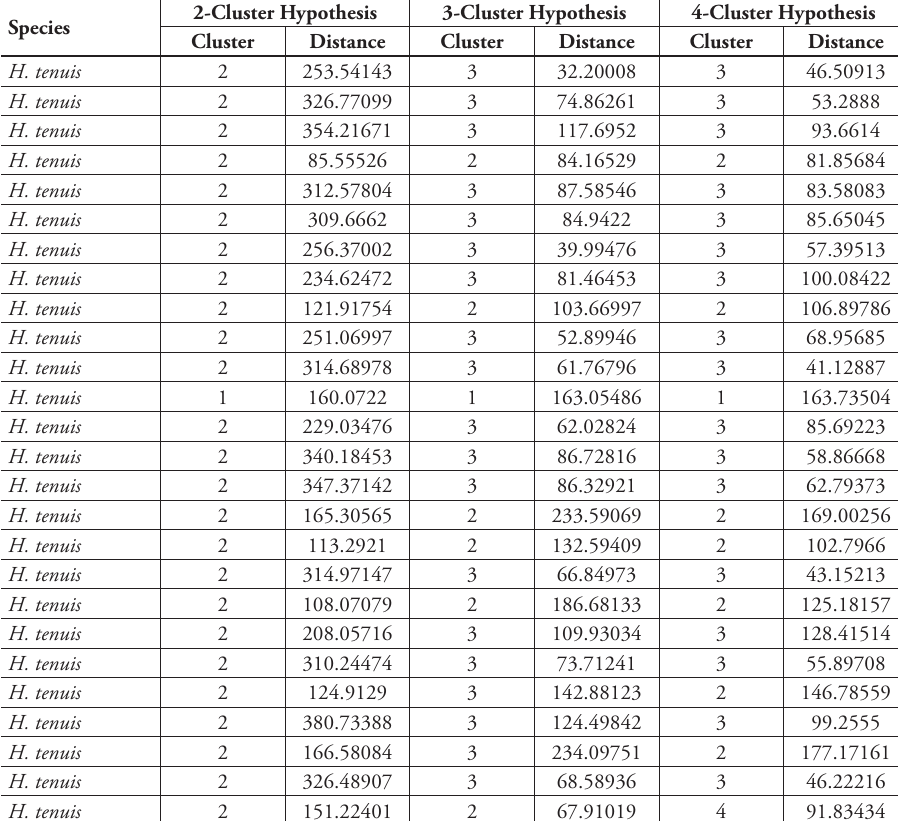
Table 2. Cluster membership under respective phylogenetic hypotheses. Insufficient morphometric data precluded analysis of 40 specimens. Cluster numeration was arbitrary. Distance was measured relative to computed cluster